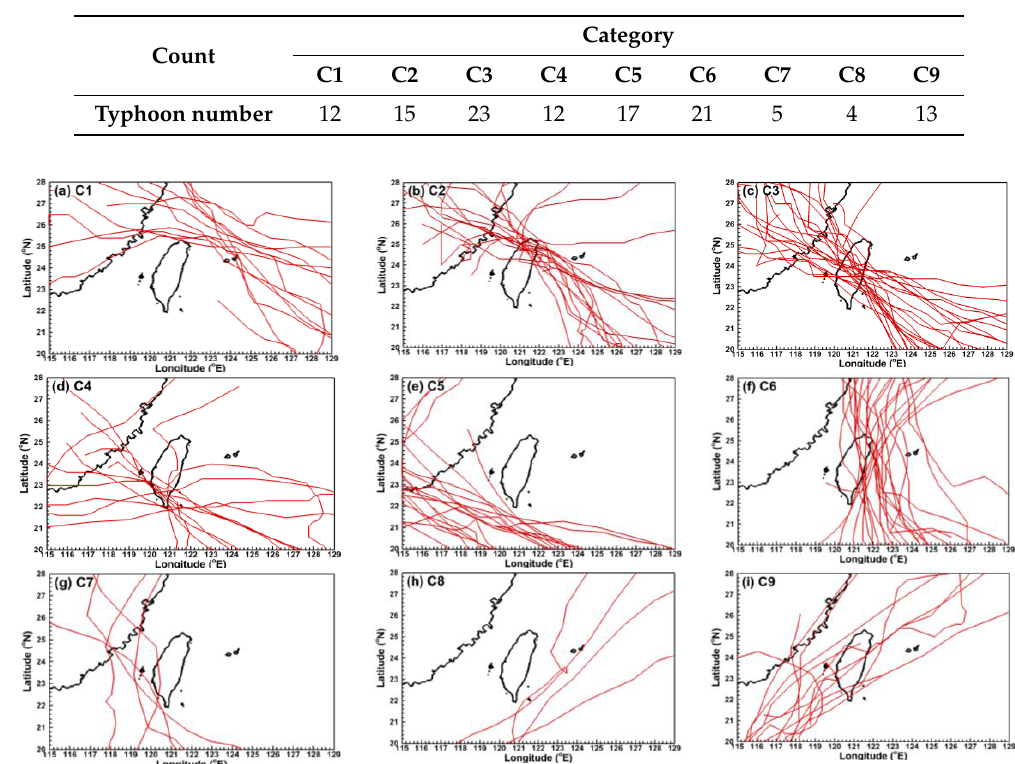
Table 1. Number of typhoon events corresponding to each category during the period 1978–2017.